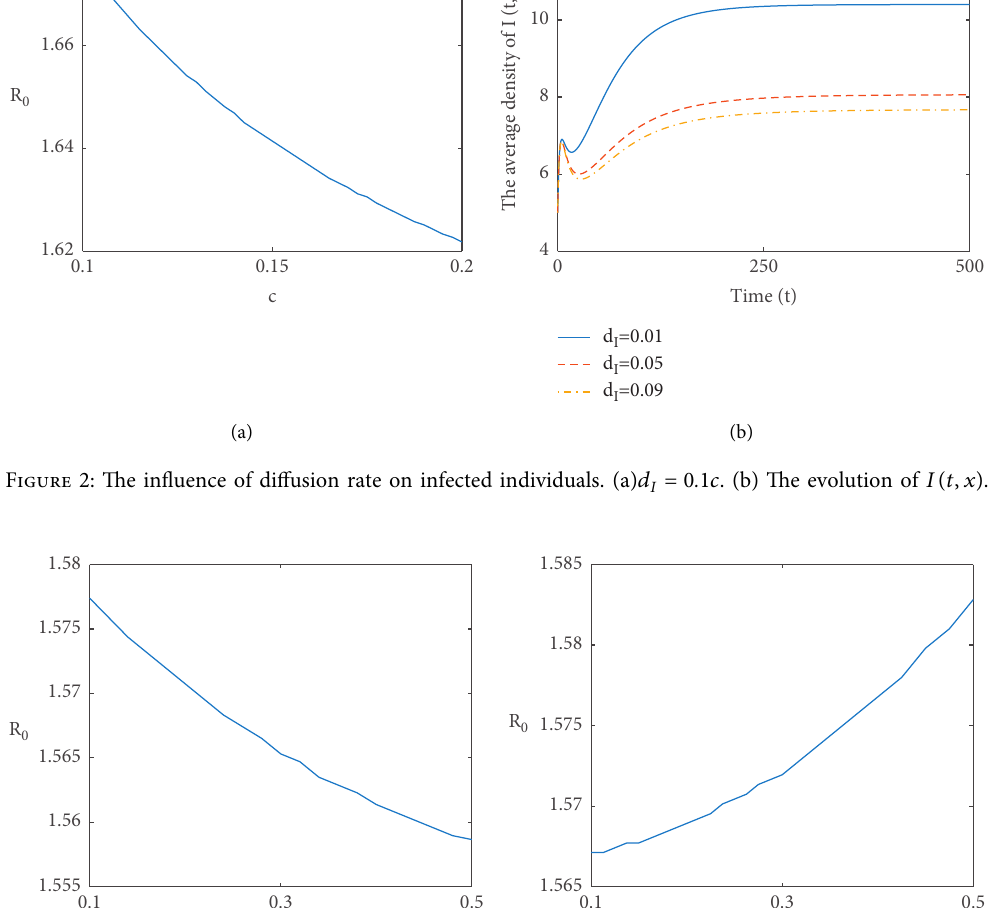
with k ( x ) � 0 . 3 × ( 1 + 0 . 8 c sin ( 2 π x )) . (a) β ( x ) � 0 . 45 × ( 1 + 0 . 5sin ( 2 π x )) ; 0